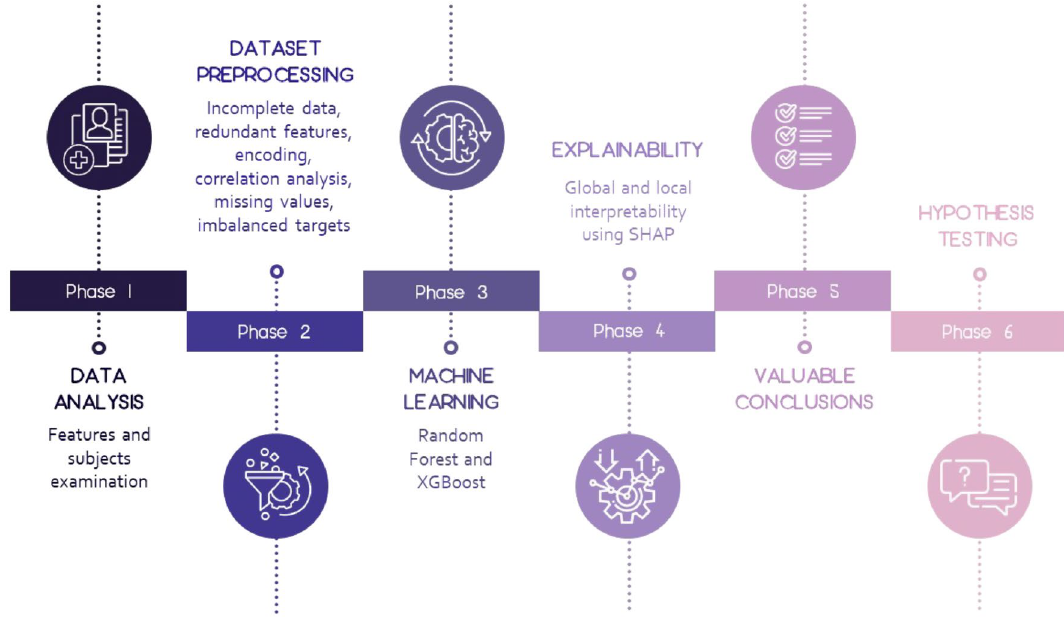
Figure 1. Methodology